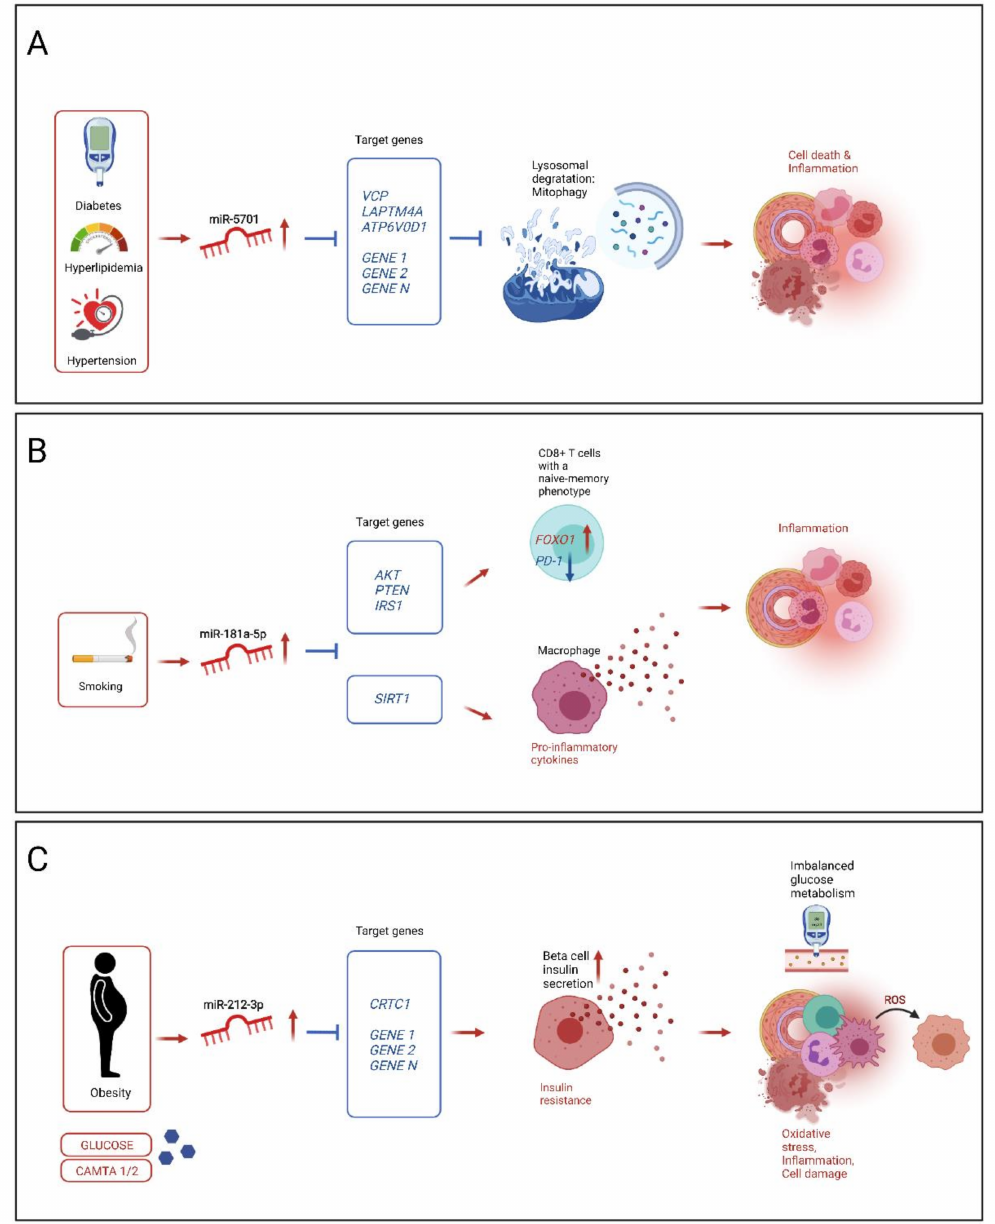
Figure 4. The proposed mechanism of action for ( A ) miR-5701. Hypertension, hyperlipidemia and/or diabetes lead to an increased expression of miR-5701 in IMA, which results in decreased expression of its putative target genes (e.g., VCP, LAPTM4A, ATP6V0D1) related to lysosomal biogenesis and mitochondrial quality control. This, on its turn, leads to impaired lysosomal degradation (mitophagy) and hence the accumulation of dysfunctional mitochondria, resulting in cell death and inflammation in the vascular tissue. ( B ) miR-181a-5p. Nicotine from cigarette smoke increases the expression of miR-181a-5p in CD8+ T cells. miR-181a-5p inhibits the expression of AKT, PTEN and IRS1, leading to increased FOXO1 activity and increased numbers of naïve-memory cells, which are known to express co-inhibitory receptor programmed death-1 (PD-1), acting as brakes on the immune system and inflammatory responses. Moreover, miR-181a-5p was identified to regulate the inflammatory response of macrophages in acute sepsis via SIRT1. ( C ) miR-212-3p. Obesity increases expression of miR-212-3p, via calmodulin binding transcription activators CAMTA1 and 2 and its target genes, stimulating insulin secretion from beta cells. CyclicAMP-Regulated Transcriptional Co-activator-1 (CRTC1) is targeted by miR-212, regulating insulin signaling and feed-back regulation of miR-212 and miR-132. Increased secretion of insulin results in insulin resistance promoting oxidative stress, inflammation and cell